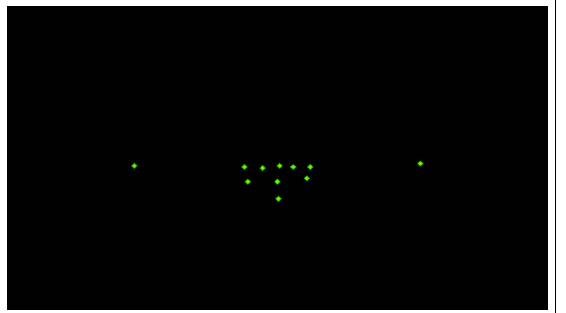
Figure 17. Formation identification data without player labels—in this experiment, the color-coded player labels have been removed from the training data, testing whether the player label information is valuable to the formation identification